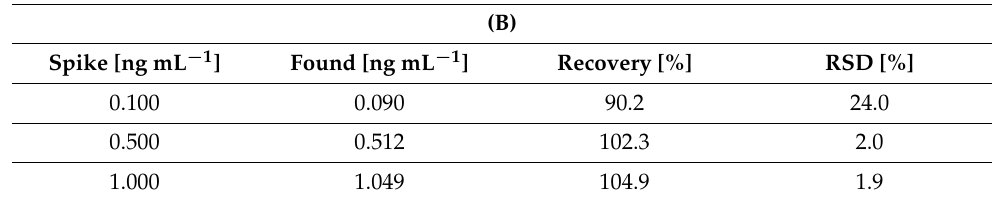
Table 1. A. Precision and recoveries of the determination of cathepsin S with the biosensor formed on the Ag/Au chip (n = 24). B. Precision and recoveries of the determination of cathepsin S with the biosensor formed on the Ag/Au chip (n = 24).